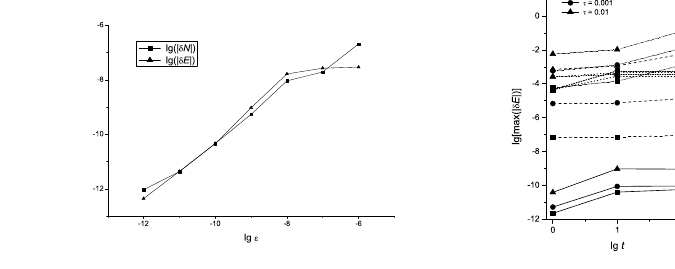
Figure 5. Logarithm of maximal deviations δ ¯ E at g = 1 , k = 0 . 1 , for different methods. (a) h =1/64, (b) τ